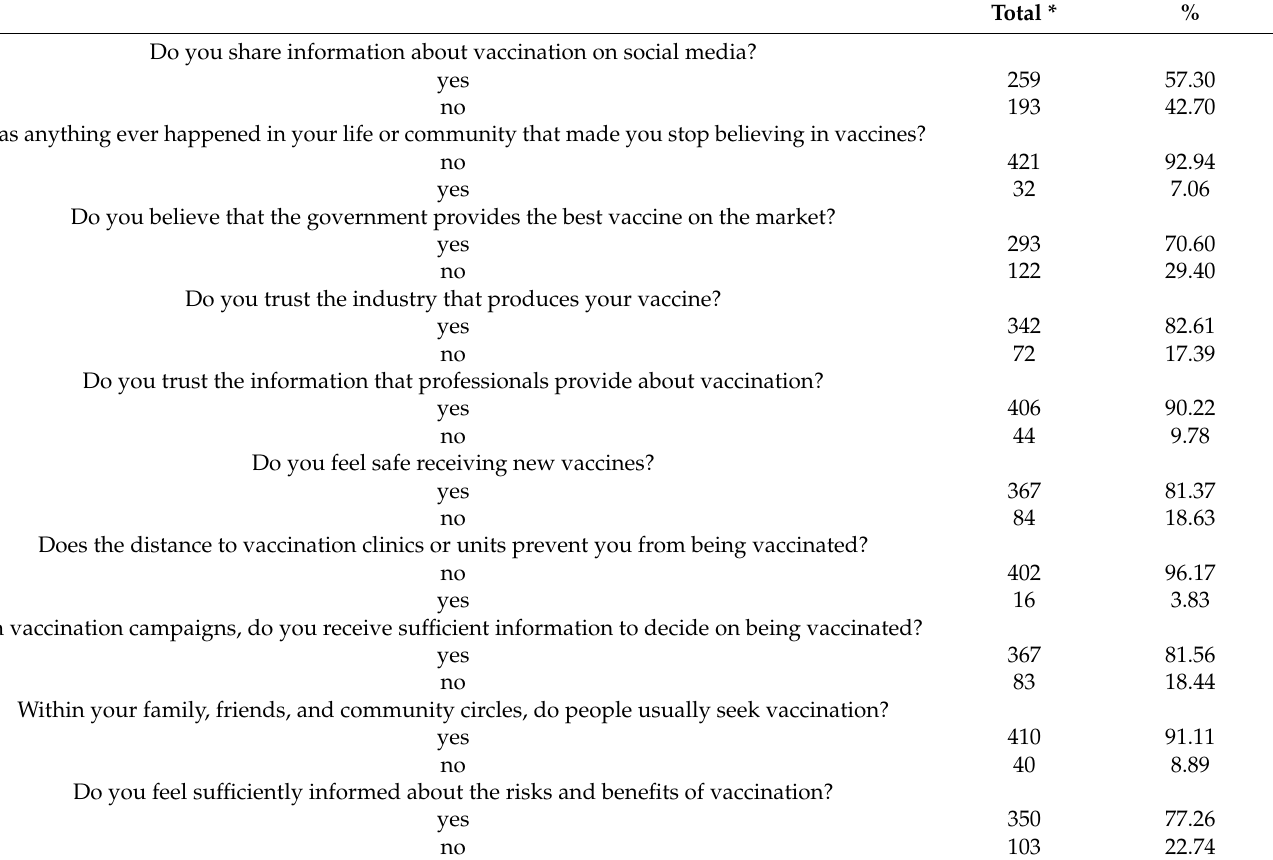
Table 2. Vaccination influences, attitudes and experiences among health workers in Bahia, Brazil, in